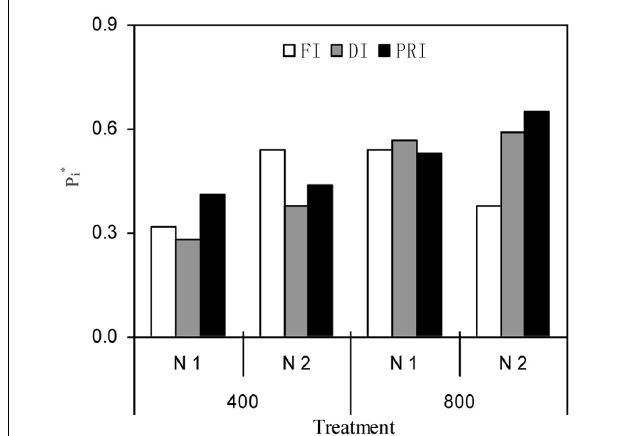
FIGURE 4 | PCA evaluation of comprehensive tomato quality attributes (15 parameters) among all treatments (the atmospheric [CO 2 ] (400 and 800 ppm), N fertilization rates (N1 and N2), and irrigation regimes (FI, DI, and alternative PRI). P i ∗ value indicates the closeness between principal components in each